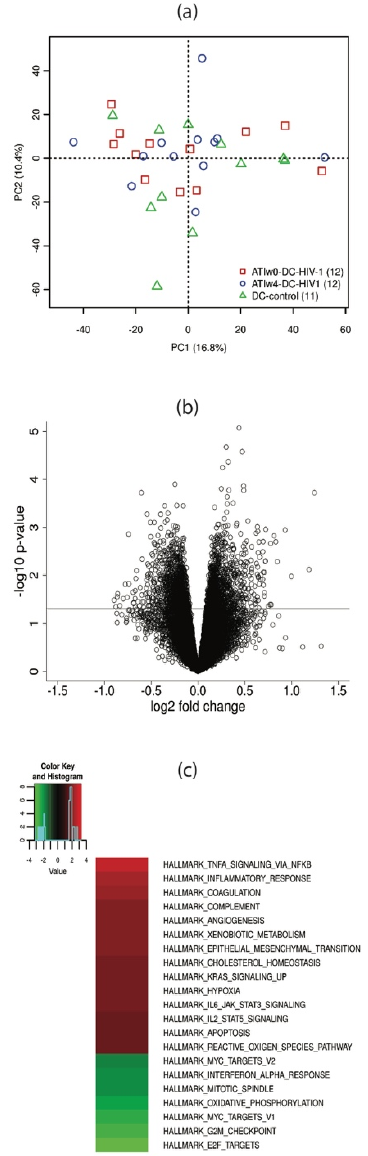
Figure 2. Differential expression analysis of mRNA between responders and non-responders in the DCV2 trial. ( a ) Principal component analysis of gene expression. Colors represent different treatment groups. No clear clustering can be observed according to the main principal components. ( b ) Volcano plot of the comparison of mRNA expression between responders and non-responders. The horizontal line corresponds to an unadjusted p -value of 0.05. Differential expression did not achieve statistical significance defined by an adjusted p -value > 0.05 in any case. ( c ) GSEA analysis of non-responders vs. responders, using the molecular signature database MSigDB (v6.0) hallmark gene set collection of the Broad Institute. At a significance level defined by a family-wise error rate (FWER) < 0.05, 14 gene sets were up-regulated (red) and 7 were down-regulated (green) in responders as compared to non-responders. Color intensity corresponds to the magnitude of the normalized enrichment score (=actual enrichment score divided by the mean of the enrichment scores against all permutations of the dataset).